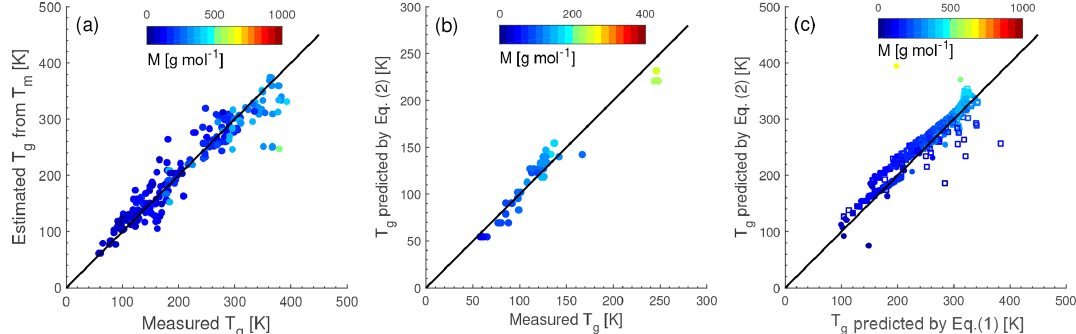
Figure A2. (a) Comparison of measured and estimated T g by the Boyer–Kauzmann rule for 251 organic compounds (Koop et al., 2011; Dette et al., 2014; Rothfuss and Petters, 2017a) with their measured T m available. The markers are color coded by molar mass. (b, c) Predicted T g using Eq. (2) compared with (b) measured T g for CH compounds and (c) predicted T g using Eq. (1) for CHO compounds. The solid line shows the 1 : 1 line. Solid circle markers represent organic compounds as compiled in Koop et al. (2011) and open square markers represent SOA oxidation products in Shiraiwa et al. (2014) in panel (c) .